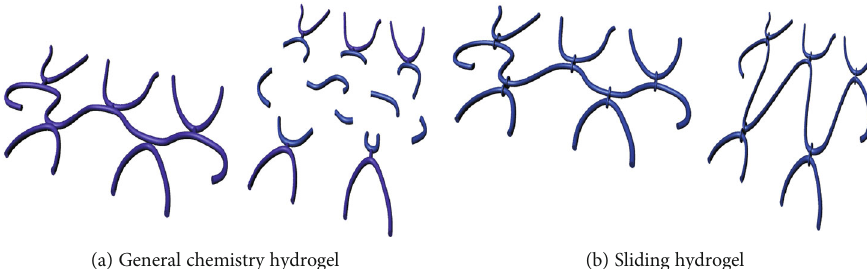
Figure 3: General chemistry hydrogel and sliding